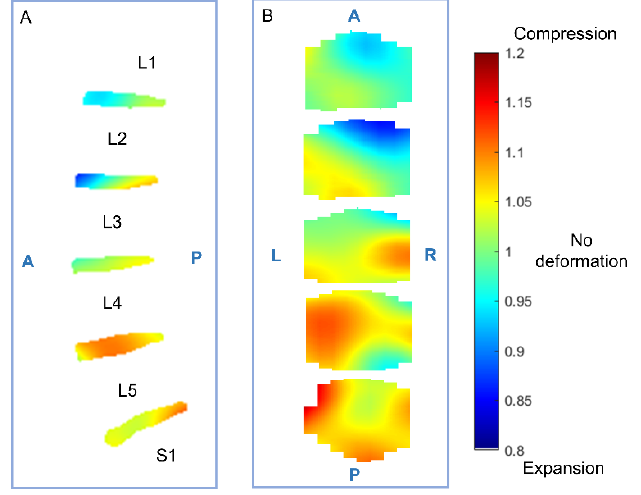
Figure 3. Heatmaps of the intradiscal deformation. Displayed as a sagittal projection ( A ), and a head–feet projection ( B ), where a Jacobian determinant larger than 1 represents compression and smaller than 1 represents expansion. Larger compression was found posteriorly in the lower lumbar spine, and generally, the compression showed a left asymmetric distribution pattern.